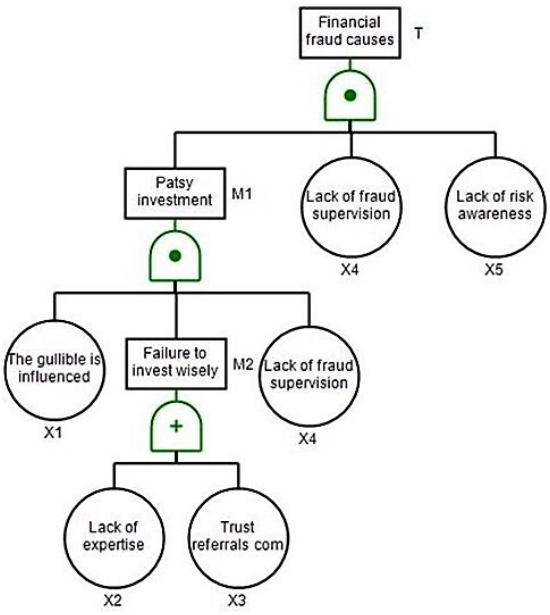
Figure 7. The fault tree of fund ‐ raising fraud.